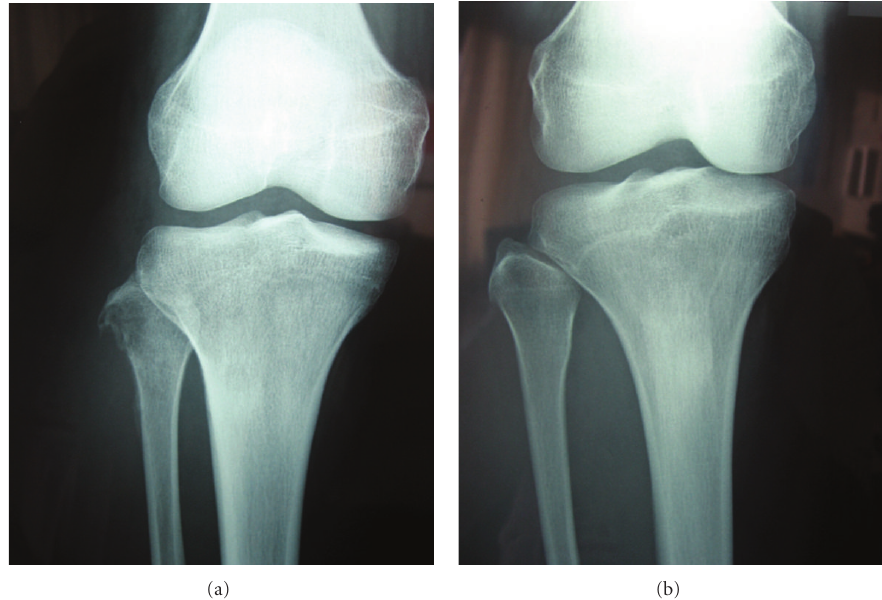
Figure 1: (a) 2 months later, the lytic lesion has rapidly progressed and destroyed the external cortical bone of the proximal peroneal head. (b) Initial right knee radiography where we notice a small bony spicule at the proximal fibula head.